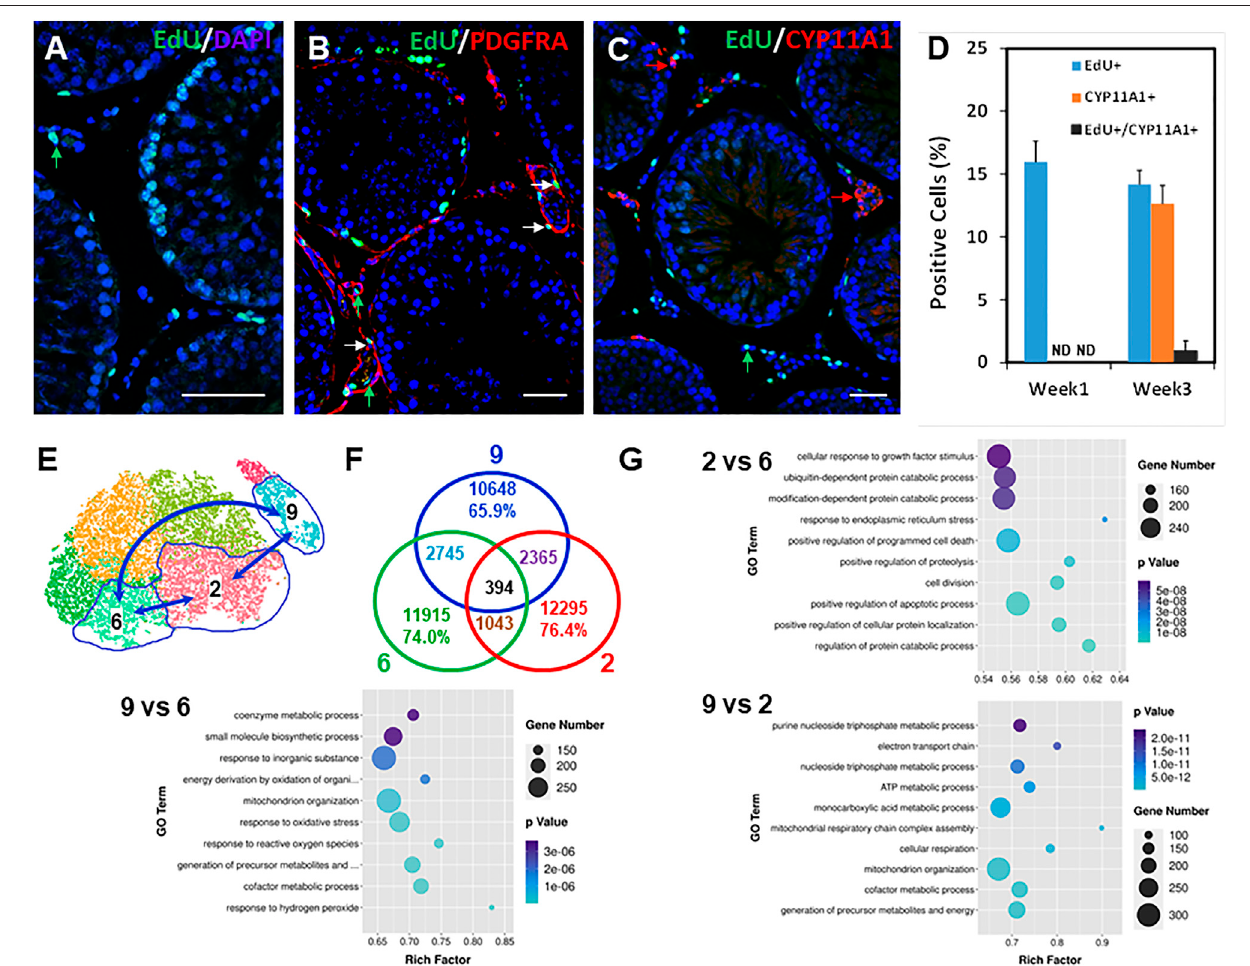
FIGURE 5 | Relationship between dividing SLCs to LC development and GO analysis of potential SLC clusters. (A) EdU labeling of the dividing interstitial cell pool duringthe fi rstweekafterEDS. (B) Co-stainingtheEdU+(green)andPDGFRA+(red)cells1 weekafterEDStreatment. (C) Co-stainingtheEdU+(green)andCYP11A1+ (red) cells 3 weeks after EDS treatment. (D) Quanti fi cation of the EdU+ (green) and CYP11A1+ cells from three animals (mean ± SE). (E) Cell clusters selected for transcriptomic comparison. (F) Differentially expressed genes (DEGs) shared by three comparing pairs. (G) Top 10 GO terms enriched for the three comparing pairs. p values for all the enriched GO terms are less than 6 × 10 − 8 . Green arrows: EdU-only positive nucleus; Red arrows: PDGFRA- or CYP11A1-only positive cells; White arrows: EdU/PDGFRA or EdU/CYP11A1 co-stained cells. Bars represent 50 μ m in length.